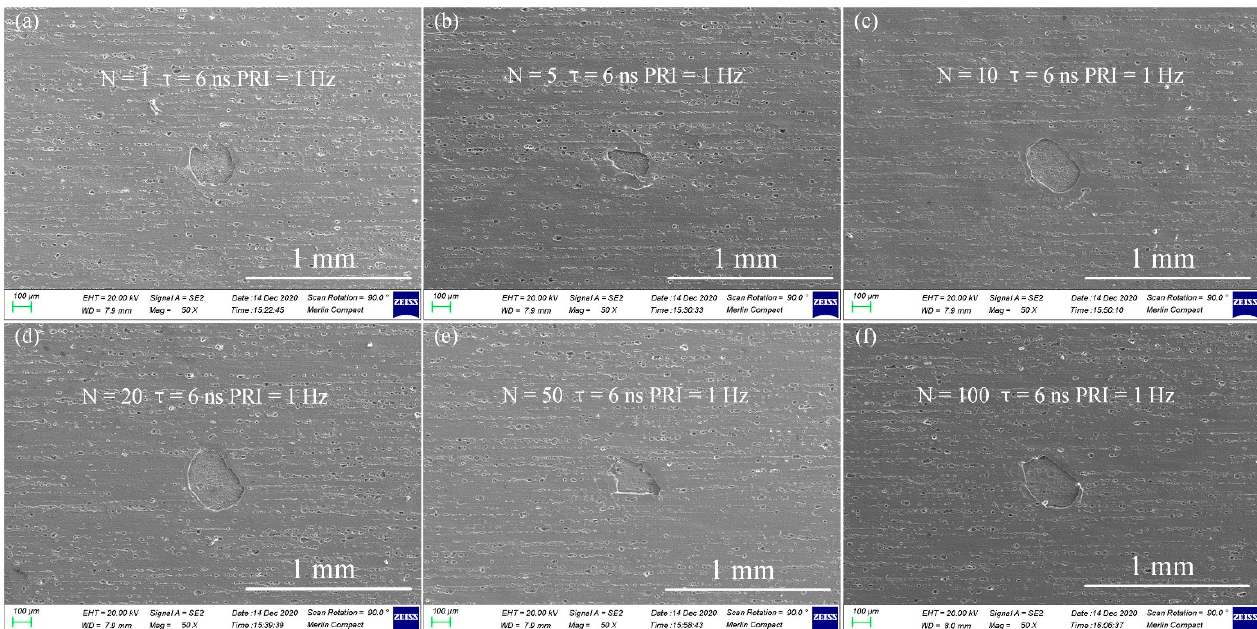
Figure 7. 1064 nm Nd:YAG laser irradiation of aluminum alloy 6061 with functional layers at a fluence of 0.5 J/cm 2 at ( a ) 1 time, ( b ) 5 time, ( c ) 10 time, ( d ) 20 time, ( e ) 50 time, ( f ) 100 time irradiation.